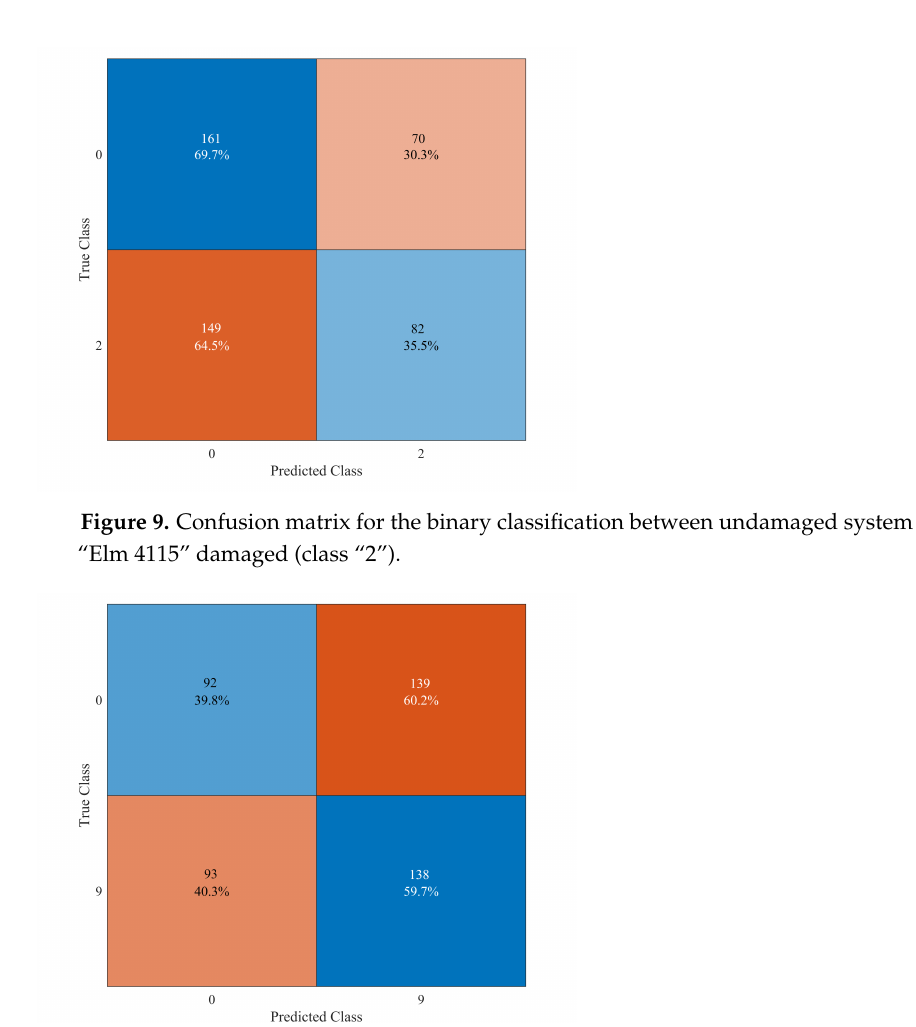
Figure 10. Confusion matrix for the binary classification between undamaged system (class “0”) and “Elm 3823” broken (class “9”).